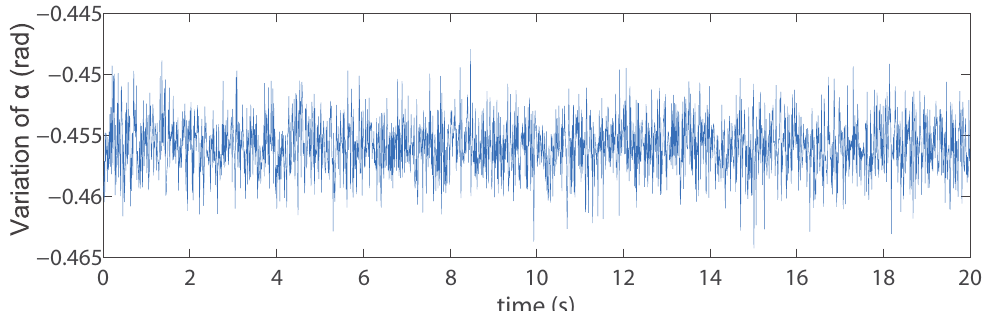
Figure 14. Variation of the image moment α for the Triangle 1.